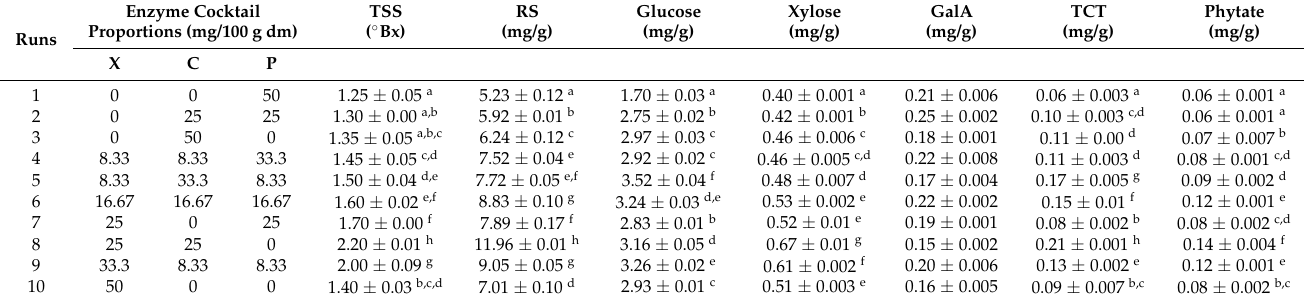
Table 1. Statistical mixture experimental design, showing the combinations of individual enzymes, xylanase (X), cellulase (C), and pectinase (P), in the cocktail and the corresponding concentration of the released components from the pericarp as analysed following enzymatic pre-treatment.